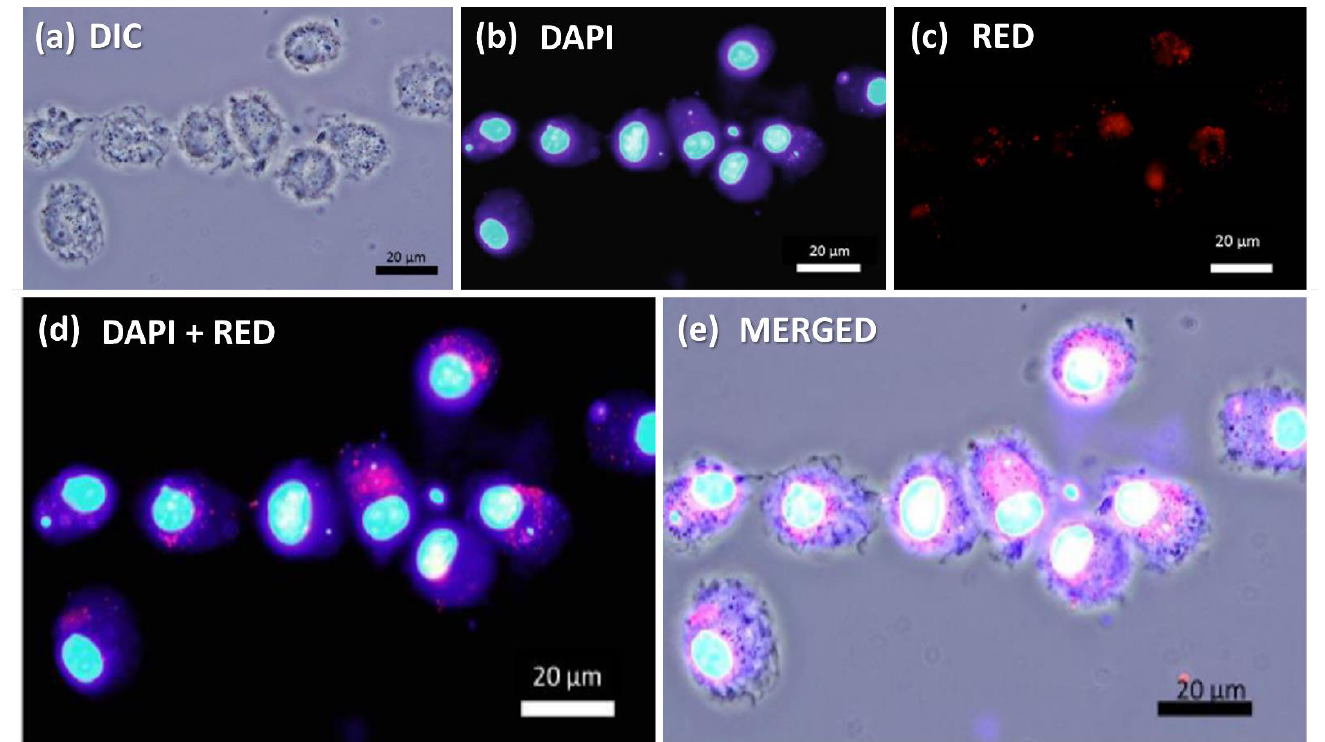
Figure 7. Fluorescence microscopy. ( a ) Differential Interference Contrast (DIC) image of BMDCs. ( b ) Blue- fluorescent DNA stain (DAPI; 4′,6 -diamidino-2-phenylindole) that exhibits enhancement of fluorescence upon binding to AT regions of dsDNA. ( c ) Red channel under blue excitation of the MNP@QD. ( d , e ) Merged images.